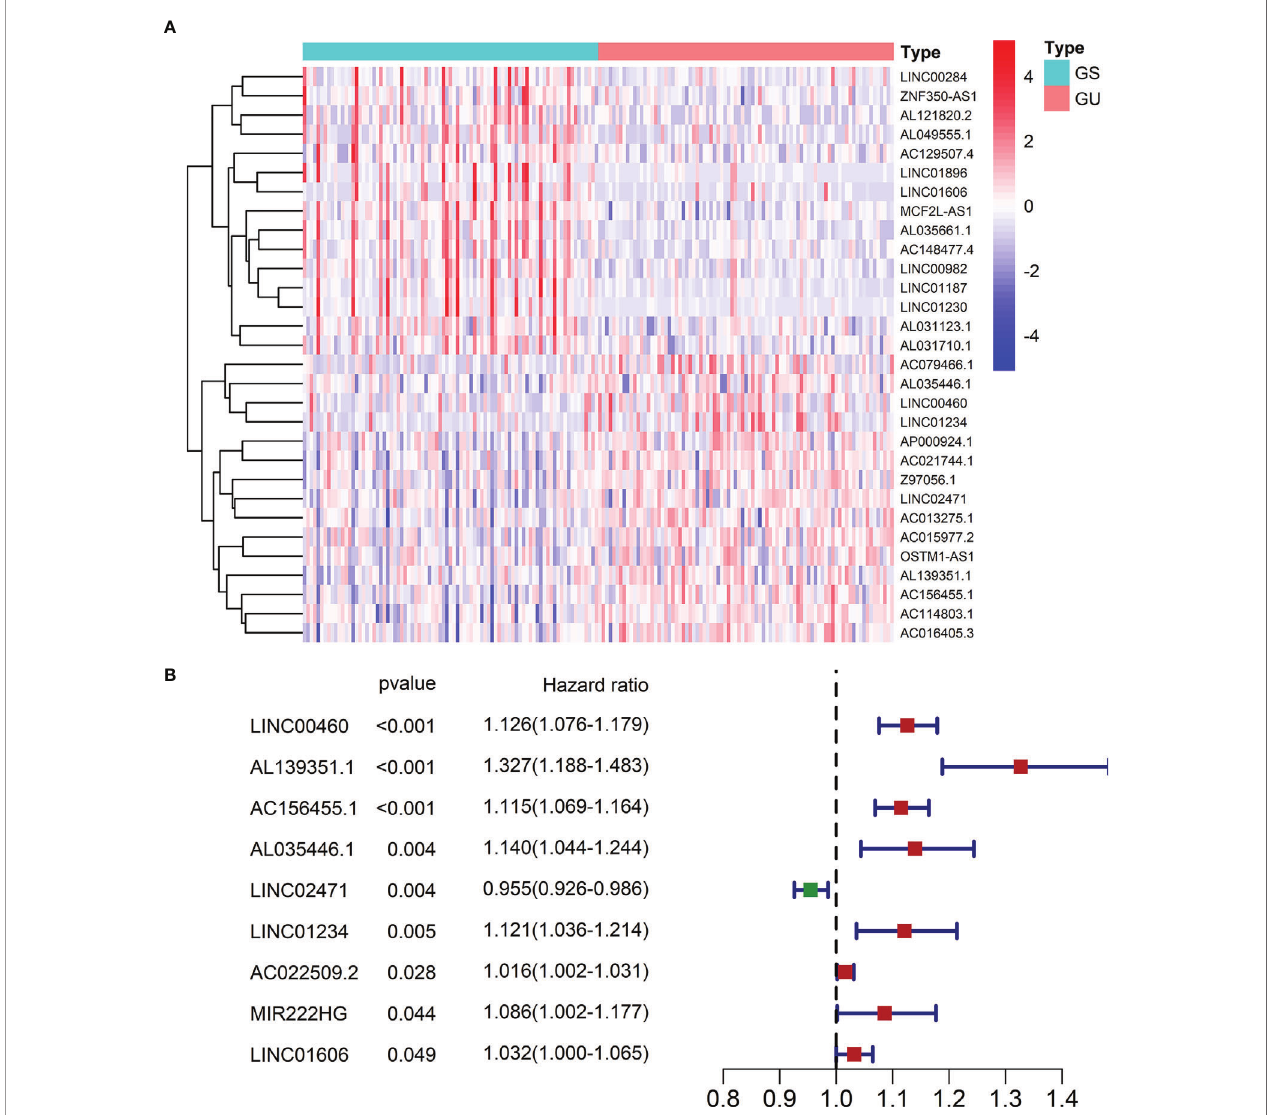
FIGURE 2 | (A) A heatmap of all GID-lncRNAs between GS-group and GU-group. Each cell represents the expression level of a lncRNA (left) in a sample (above). Red means high expression and blue means low expression. The expression values were log2 transferred before mapping. (B) OS-related GID-lncRNAs recognized by time-dependent univariate Cox